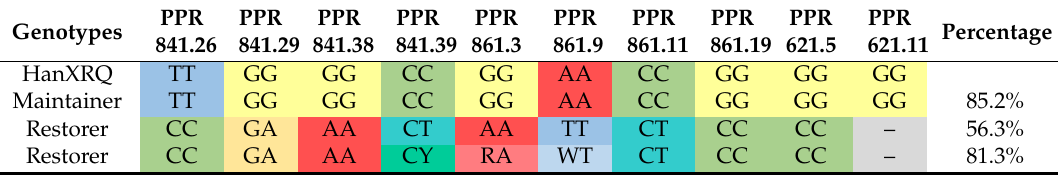
Table 4. Haplotypes based on the 10 significantly with fertility restoration associated SNPs.